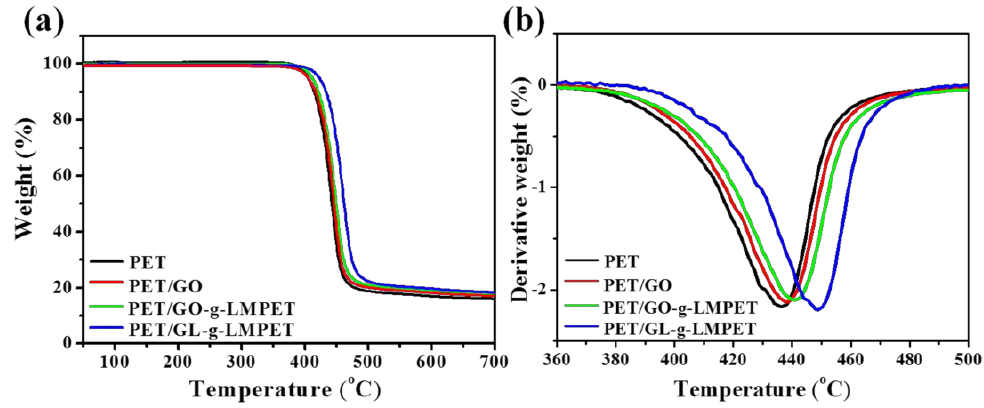
Figure 11. ( a ) TGA curves of pure PET, PET/GO, PET/GO- g -LMPET, and PET/GL-g-LMPET; ( b ) DTG curves of pure PET, PET/GO, PET/GO- g -LMPET, and PET/GL- g -LMPET.